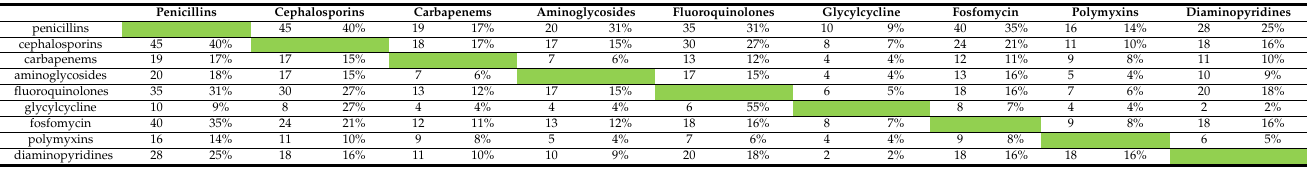
Table 1. Multidrug resistance. The level of combined resistance to couples of families of antibiotics in the period between April and September 2016 (from the database described in Section 2.2).